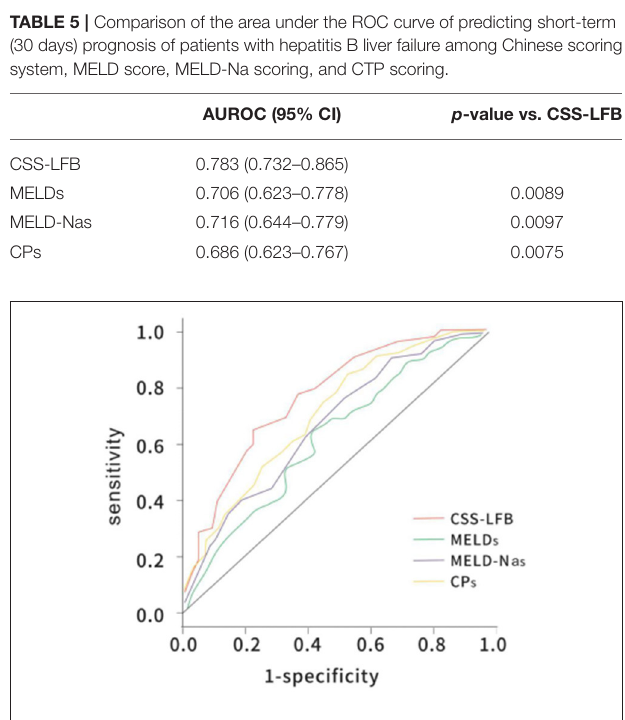
FIGURE 5 | The ROC curve of predicting long-term (180 days) prognosis of patients with hepatitis B liver failure among the Chinese scoring system, MELD